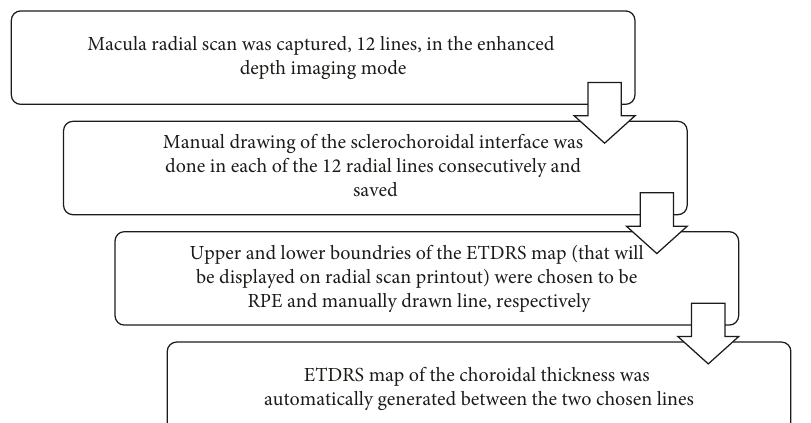
Figure 2: Schematic diagram showing the different steps performed to obtain the choroidal thickness